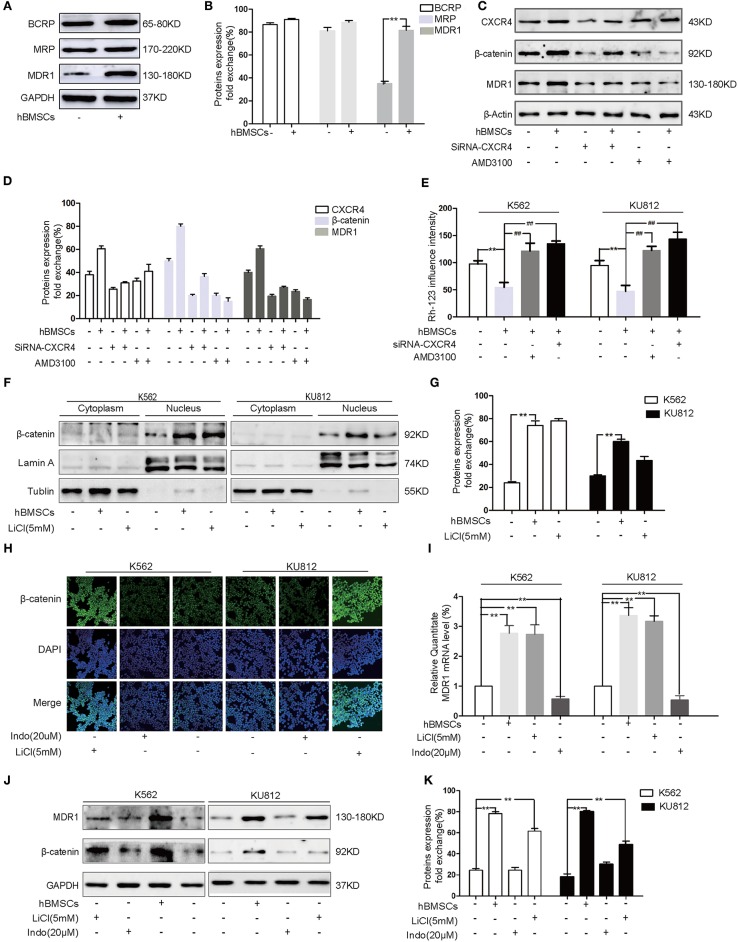
The nuclear-translocation of β-catenin could regulate P-gp. (A) Western blot analysis in K562 cells co-cultured with hBMSCs for 48 h. (B) Western blot analysis of BCRP, MRP and P-gp. (C,D) Western blot analysis and (E) Intracellular Rh-123 fluorescence detection after K562 cells being treated with AMD3100 or CXCR4 Si RNA and co-cultured with or without BMSCs. (F,G) Western blot analysis of β-catenin in CML cells in nuclear and cytoplasm, respectively, and (H) immunofluorescence detection of the distribution of β-catenin in K562 and KU812 cells treated with LiCl. MDR1 mRNA and protein expression was detected by (I) RT-PCR assay and (J,K) western blot analysis in K562 and KU812 cells treated with LiCl or 20 μM Indo. Data (B,E,G,I,K) were shown as Means ± SD for three independent experiments (*p < 0.05, **p < 0.01, and ##p < 0.01).